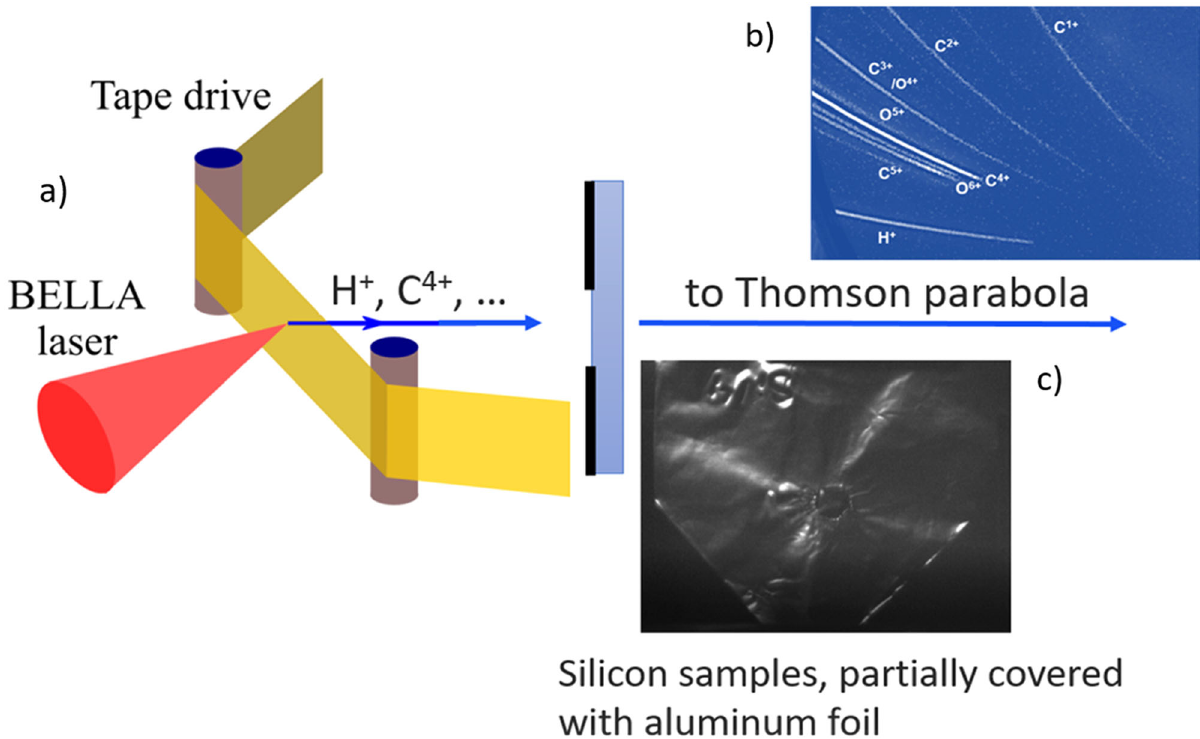
Fig. 1 Schematic of the experimental setup (not to scale). a Schematic of the tape drive and ion target assembly, b example of a Thomson parabola (TP) spectrum dominated by C 4 + and protons (H + ) with energies up to 8 MeV. c Following tuning of laser conditions using the TP, silicon samples were inserted for exposure to proton and ion pulses. A time-lapse video of a multi-shot series is shown in Supplementary Note